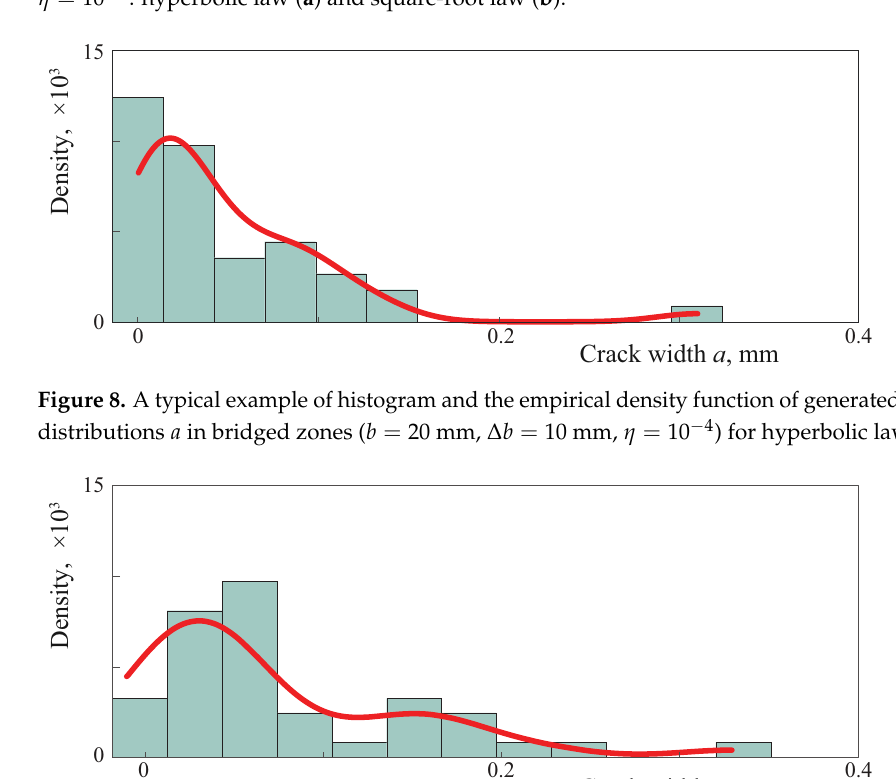
Figure 7. Examples of generated crack distributions for bridged cracks at b = 20 mm, ∆ b = 10 mm, η = 10 − 4 : hyperbolic law ( a ) and square-root law ( b ).